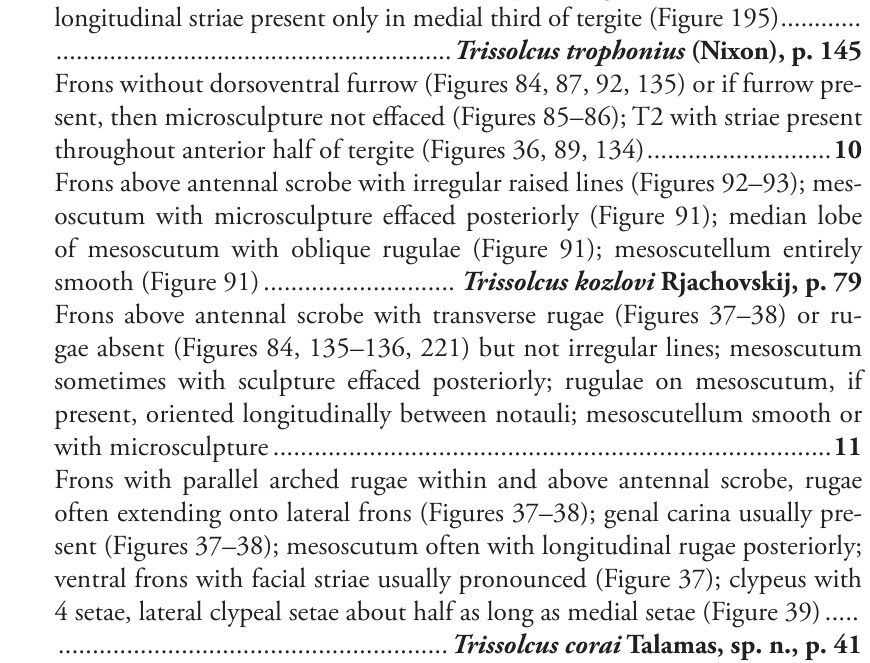
Frons between median ocellus and antennal scrobe with a dorsoventral fur- row surrounded by area of effaced microsculpture (Figures 196–197); T2 with longitudinal striae present only in medial third of tergite (Figure 195) ............